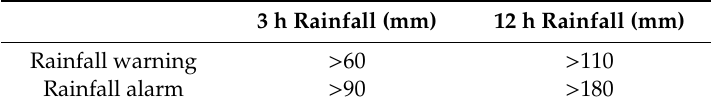
Table 2. Rainfall forecasting standard (Korea Meteorological